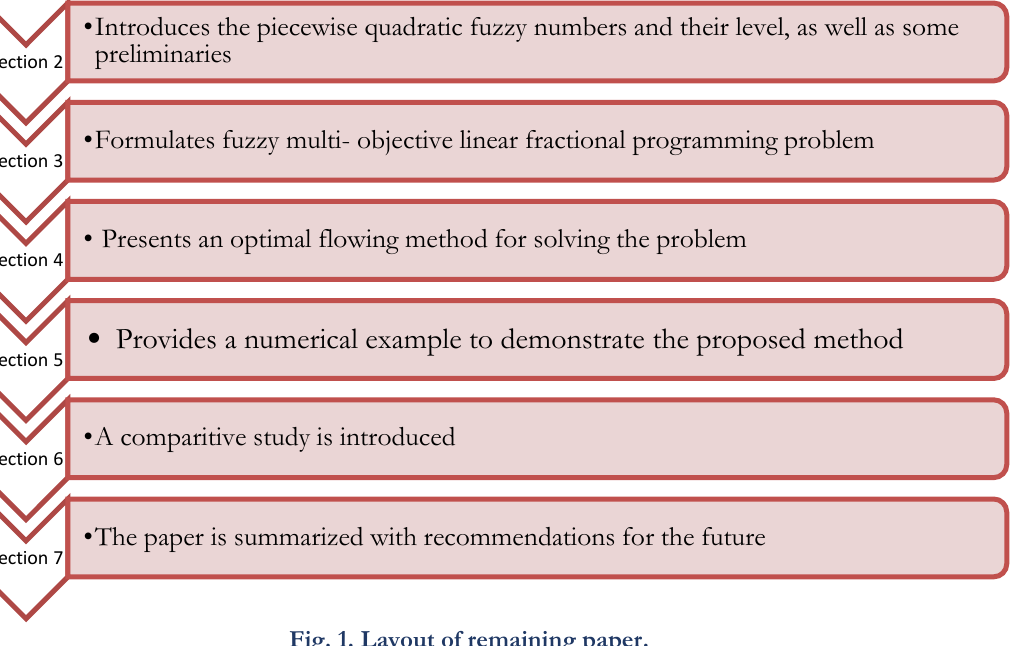
Fig. 1. Layout of remaining